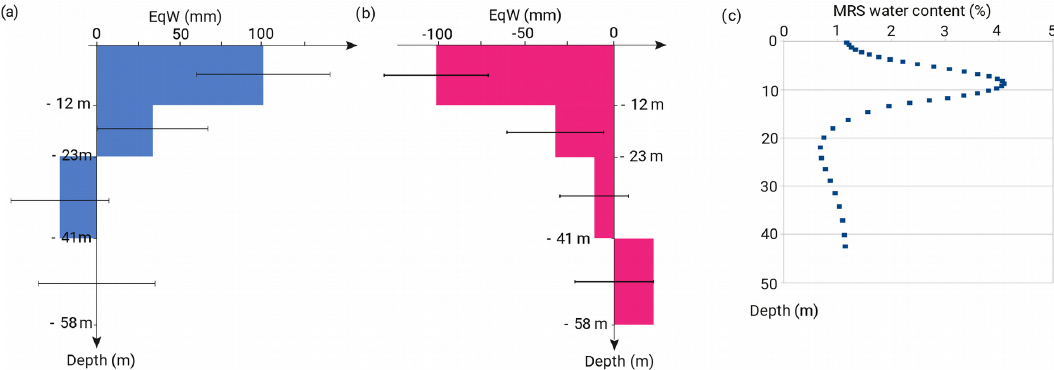
Figure 7. S2D gravity difference function of depth at the BESS site for the (a) recharge period (t 2 –t 4 ) in 2010, (b) and discharge period (t 4 –t 5 ) in 2011; (c) MRS profile of May 2011 at the BESS site.